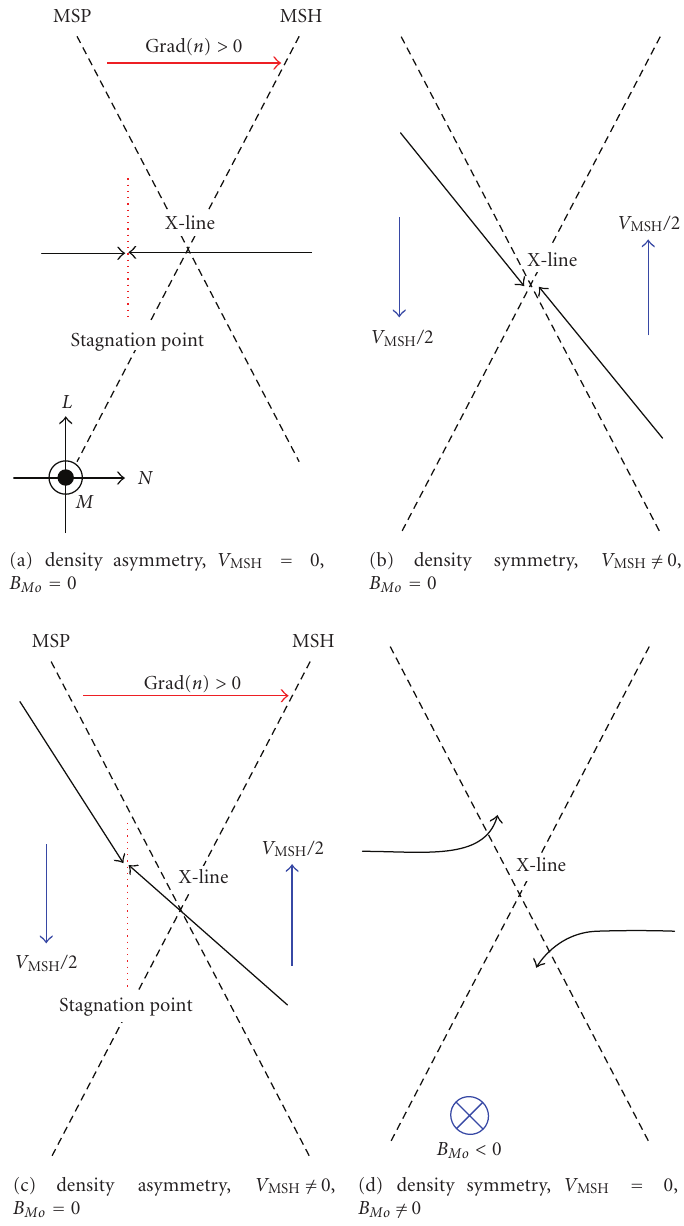
Figure 1: A schematic diagram showing why an X-line should move in the magnetopause reconnection situation. (a) Shift of stagnation point towards the magnetospheric side in the presence of density asymmetry. Here, neither a velocity shear nor a guide field is imposed. (b) The e ff ect of a velocity shear in a density symmetric case. The inflow towards the X-line is slanted from the current sheet normaldirection. (c) The ion flow pattern at the X-line when density asymmetry and velocity shear are combined. The X-line site is occupied by magnetosheath ions having nonzero component along the current sheet. (d) The e ff ect of nonzero guide field in a density symmetric case. Due to the Lorentz force near the di ff usion region, the inflow towards the X-line becomes slanted from the current sheet normal direction. Two plasma populations are set in the initial